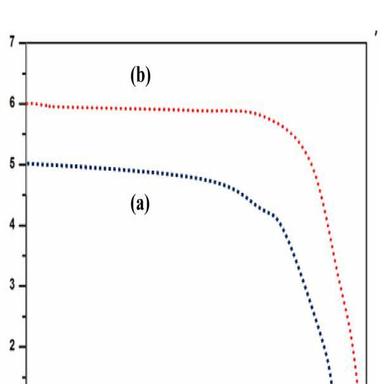
Current density–voltage (I–V) curves for the DSSC's fabricated from (a) SnO2 coated GCE in 0.1 M KCl and (b) CdO-SnO2 nanocomposite material GCE in